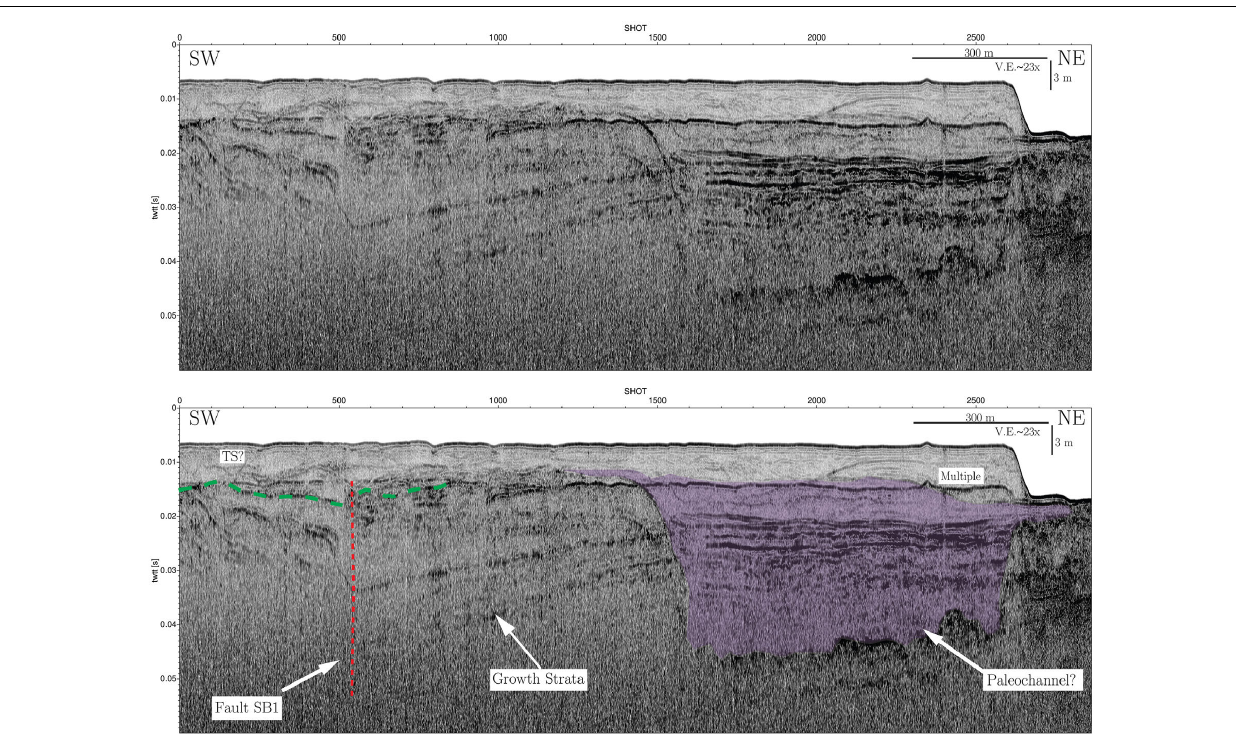
FIGURE 9 | Chirp profile SSB06 across the Sweetwater paleochannel. Red dashed line is location of Fault SB1. Green dashed horizon is the interpreted subaerially exposed surface from the Last Glacial Maximum sea level low-stand. Purple unit is interpreted channel-fill deposit. Location shown in Figure 7